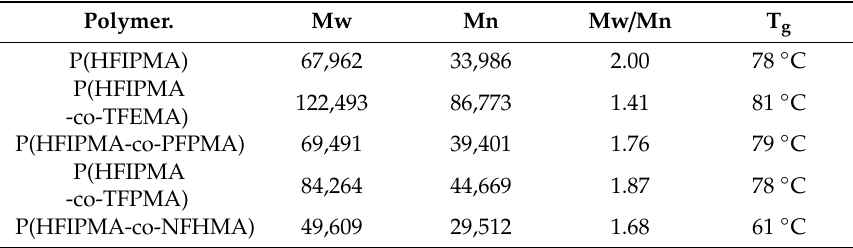
Table 1. Physical properties of the polymers.